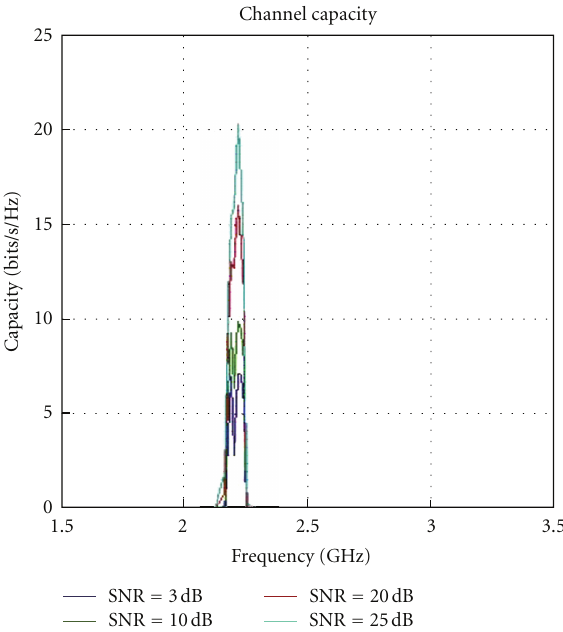
Figure 17: 3 antennas on the mid of the faces—measured S parameters.